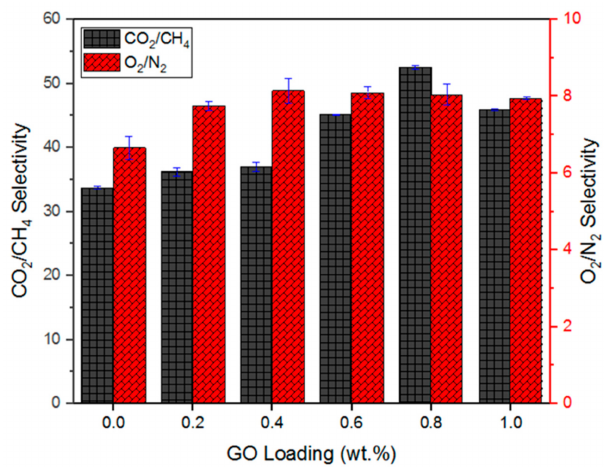
Figure 8. Gas pair selectivity performance of the GO / Pebax-hybrid coated